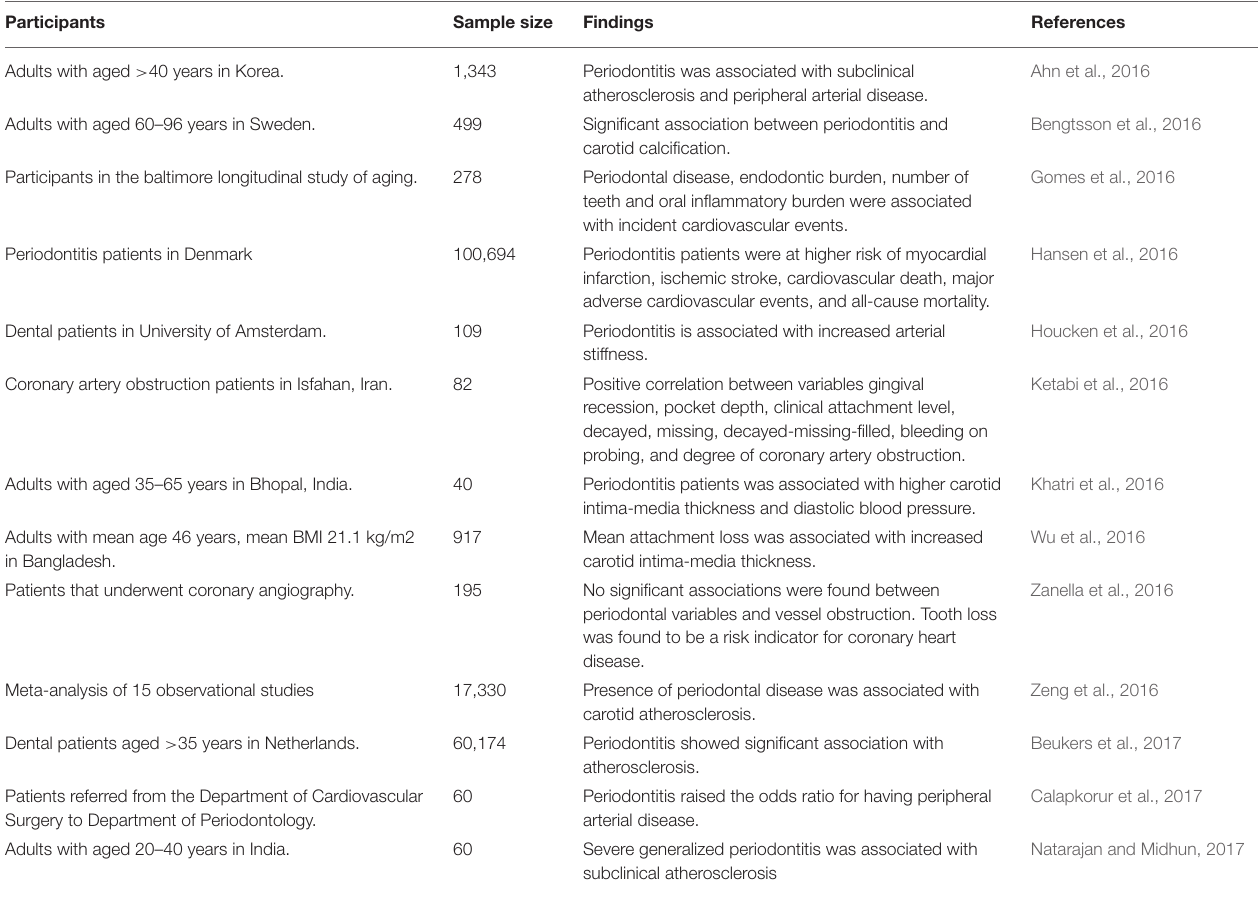
TABLE 1 | Association between periodontal disease and cardiovascular